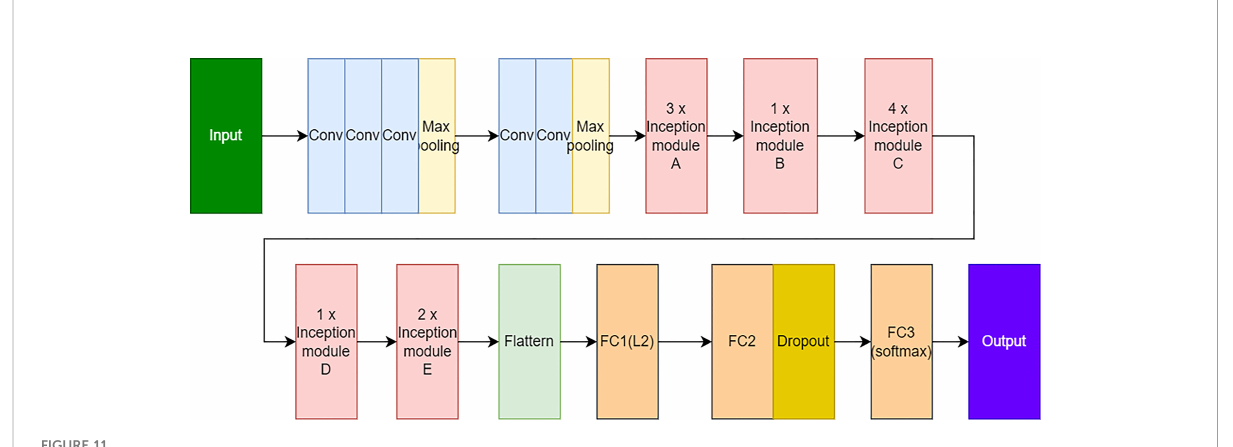
FIGURE 11 The network structure of designed InceptionV3